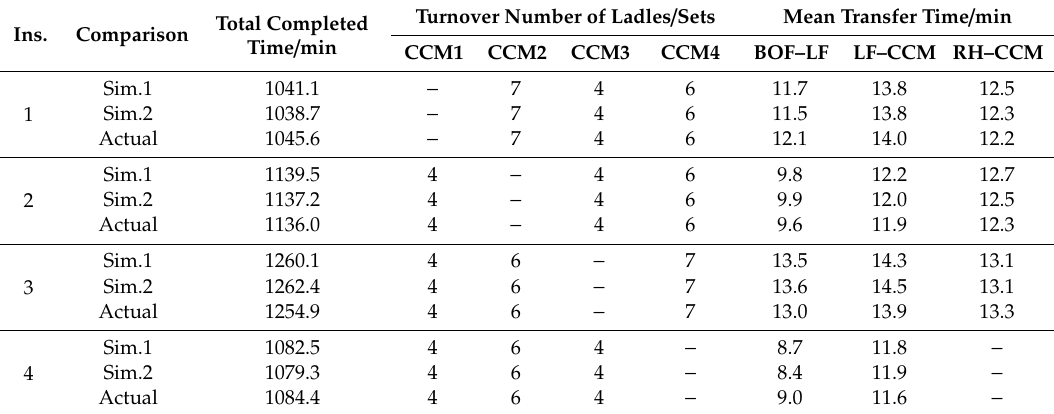
Table 5. Comparisons on performance indices between the simulated and the actual scheduling.